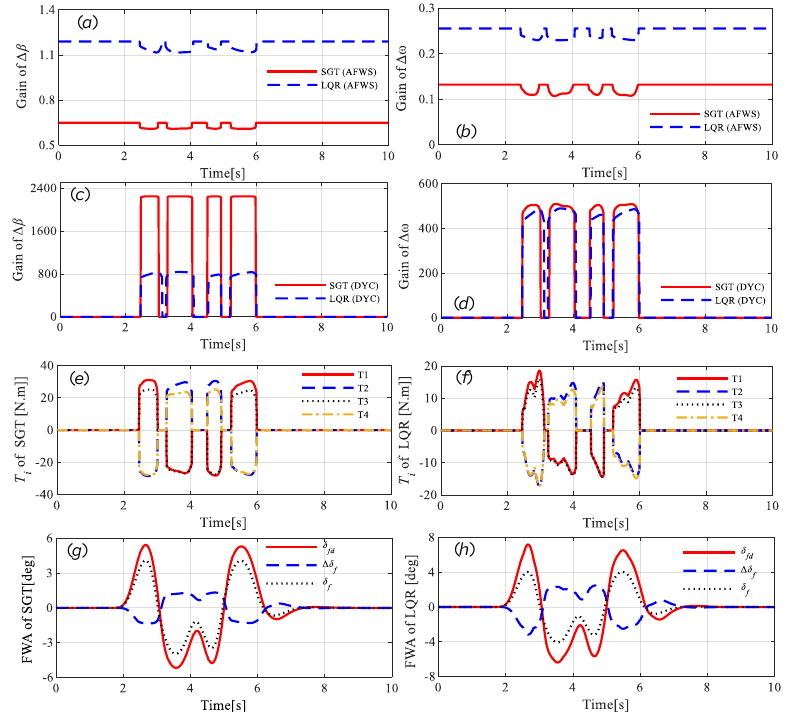
Figure 10. State gains and control inputs of DLC test at 100 km/h. ( a ) Gain of Δ β (AFWS); ( b ) Gain of ∆ ω (AFWS); ( c ) gain of ∆ β (DYC); ( d ) gain of ∆ ω (DYC); ( e ) additional torque of SGT; ( f ) additional torque of LQR; ( g ) front wheel angle (FWA) of SGT; ( h ) front wheel angle (FWA) of LQR.